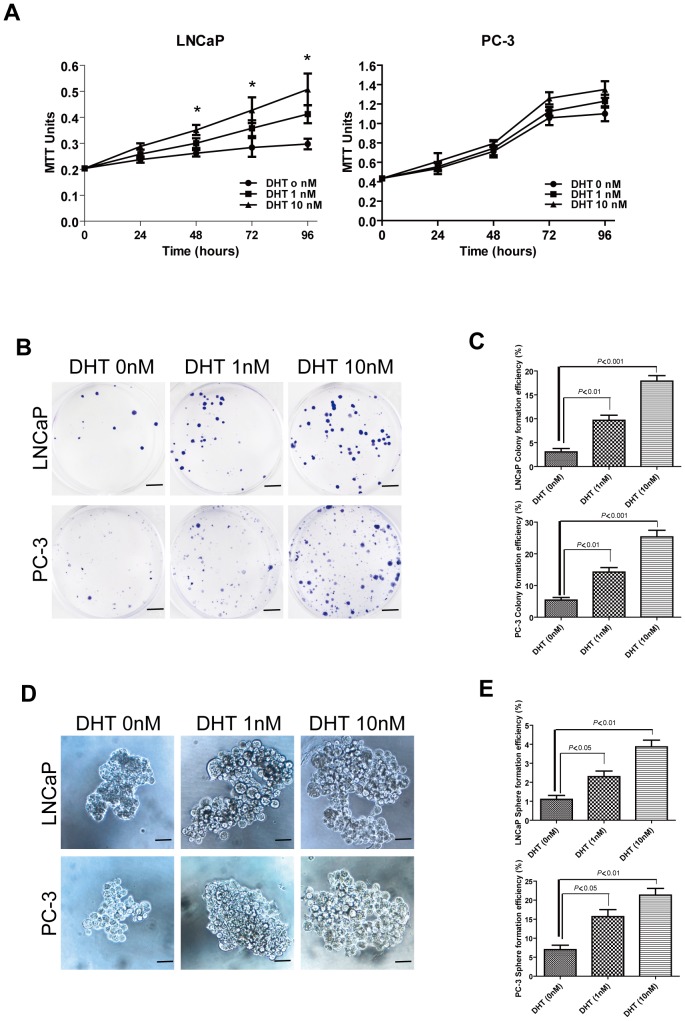
DHT induces cell growth and clonogenicity in prostate cancer cell lines.(A) Cell growth curves show statistically significant difference in LNCaP cells with/without DHT treatment, but not in PC-3 cells (* means P<0.05). (B) Representative photographs of colony formation in both cell lines demonstrate that more colonies were formed by 1 nM DHT treatment and even more colonies were obtained by 10 nM DHT treatment (bar scale: 50 mm). (C) Histograms of colony formation efficiency show statistically higher efficiencies in the cells treated with low concentration of DHT (P<0.01), and even higher efficiencies in the cells by high concentration of DHT (P<0.001). (D) Representative photographs for sphere formation for both cell lines in the cells with/without DHT treatment (bar scale: 50 µm). (E) Histograms for sphere formation efficiency show higher efficiencies in the cells added with 1 nM DHT (P<0.05), and even higher efficiencies in the cells stimulated with 10 nM DHT (P<0.01).